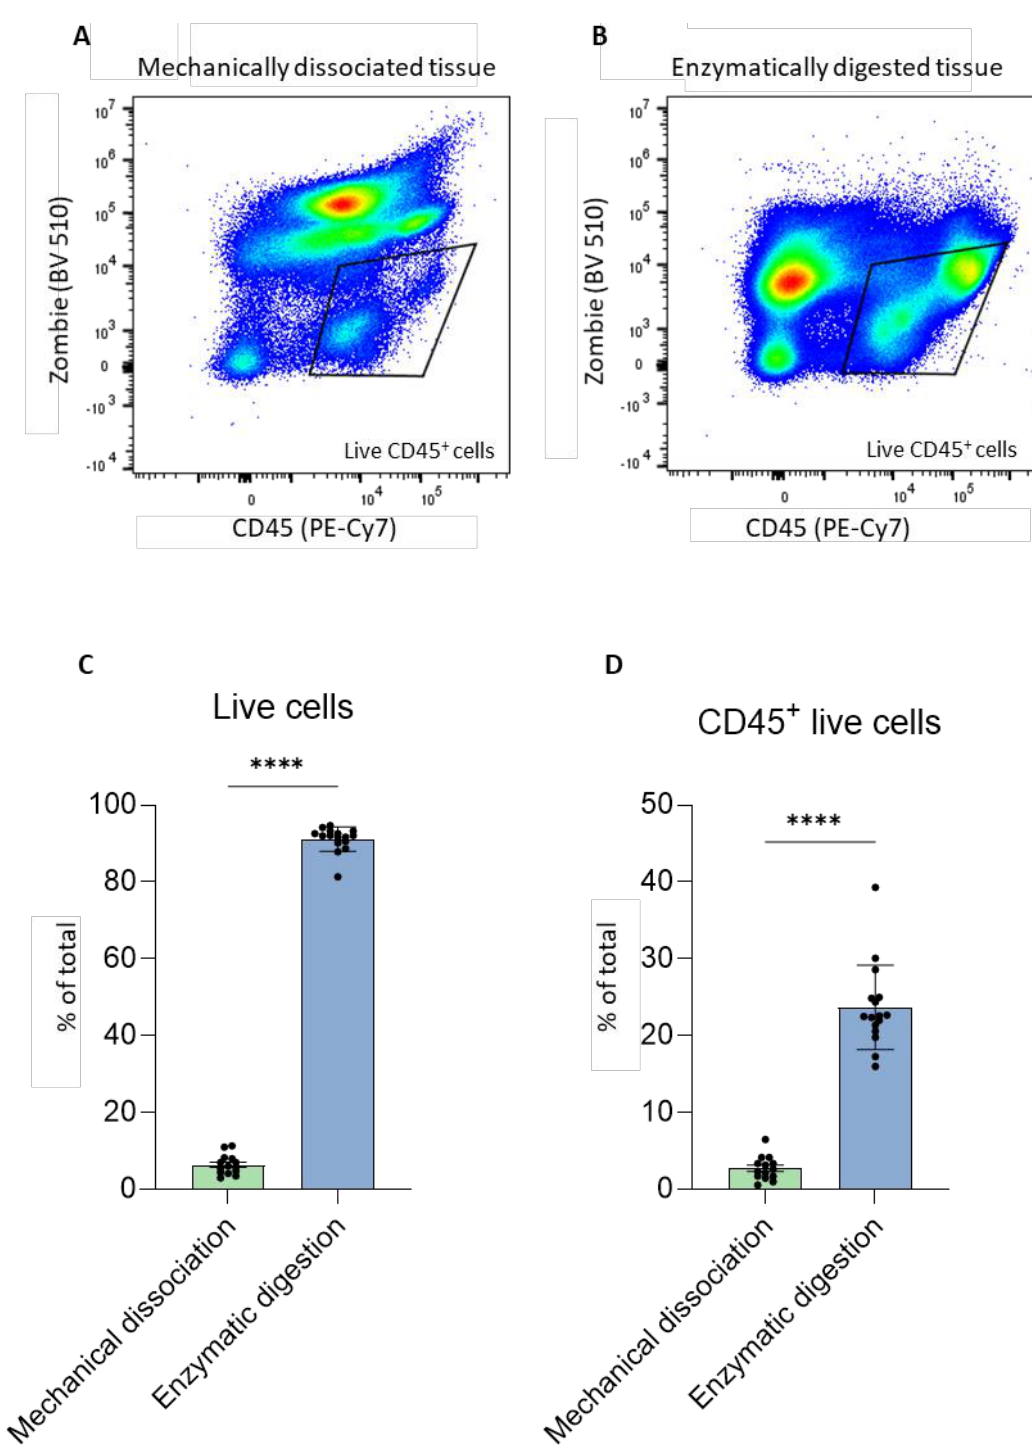
Figure 2. Comparison between mechanical and enzymatic tumor dissociation. FACS gating strategy to assess the percentage of Zombie − (live) and live CD45 + cells obtained using mechanical ( A ) and enzymatic/mechanical (using gentleMACS TM Dissociator) ( B ) tumor dissociation. Percentage of Zombie − (live) cells ( C ) and live immune cells (CD45 + , ( D )) using mechanical dissociation and enzymatic digestion is shown, each dot represents one tumor. Statistical analysis was performed using Student’s t -test; n ≥ 15 (per group) from three independent experiments; p ≤ 0.0001 (****).